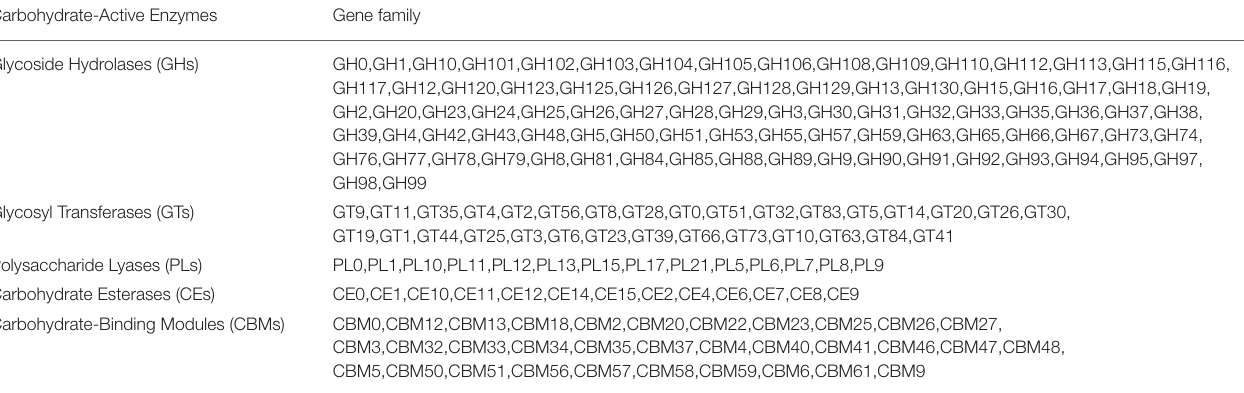
TABLE 3 | Enzymes related to carbohydrate degradations.